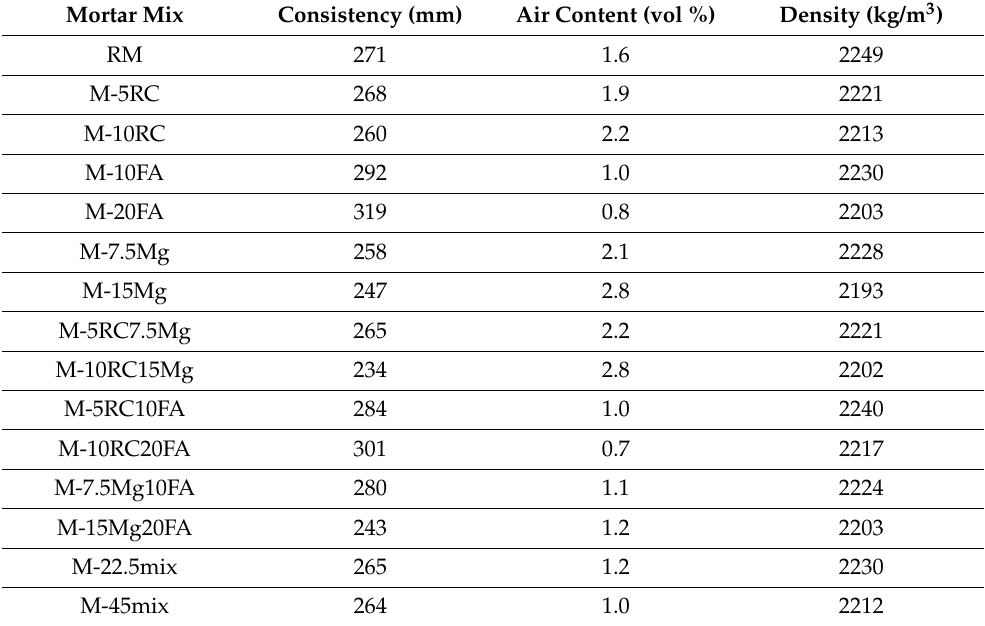
Table 4. Fresh-state properties of the